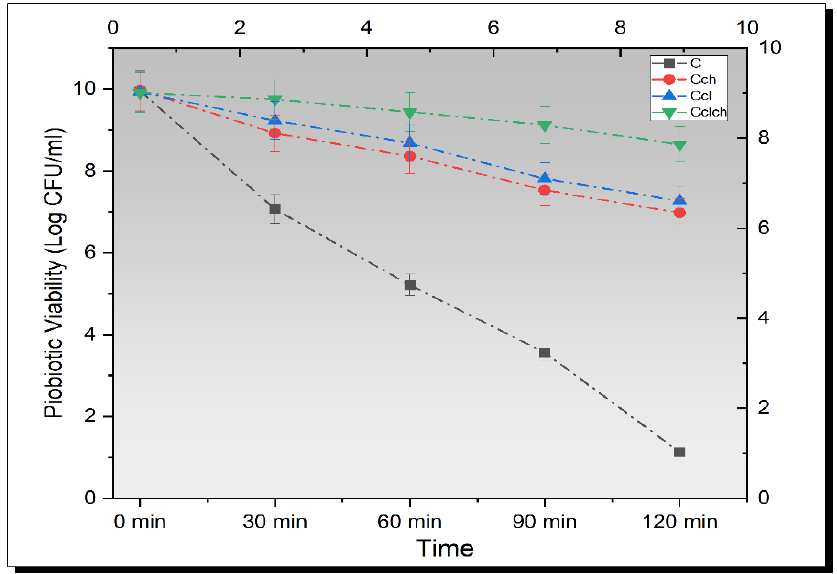
Figure 3. Viability of un-encapsulated and encapsulated (cellulose, chitosan, and cellulose–chitosan hybrid cells) probiotic microgels under simulated intestinal fluid during storage intervals (0, 30, 60, 90, and 120 min) compared with control. Each line represents mean value for viability of treatments. C (un-encapsulated probiotics), Cch ( L. plantarum encapsulated with chitosan), Ccl ( L. plantarum encapsulated with cellulose), and Cch-cl ( L. plantarum encapsulated with chitosan and cellulose hybrid cells).